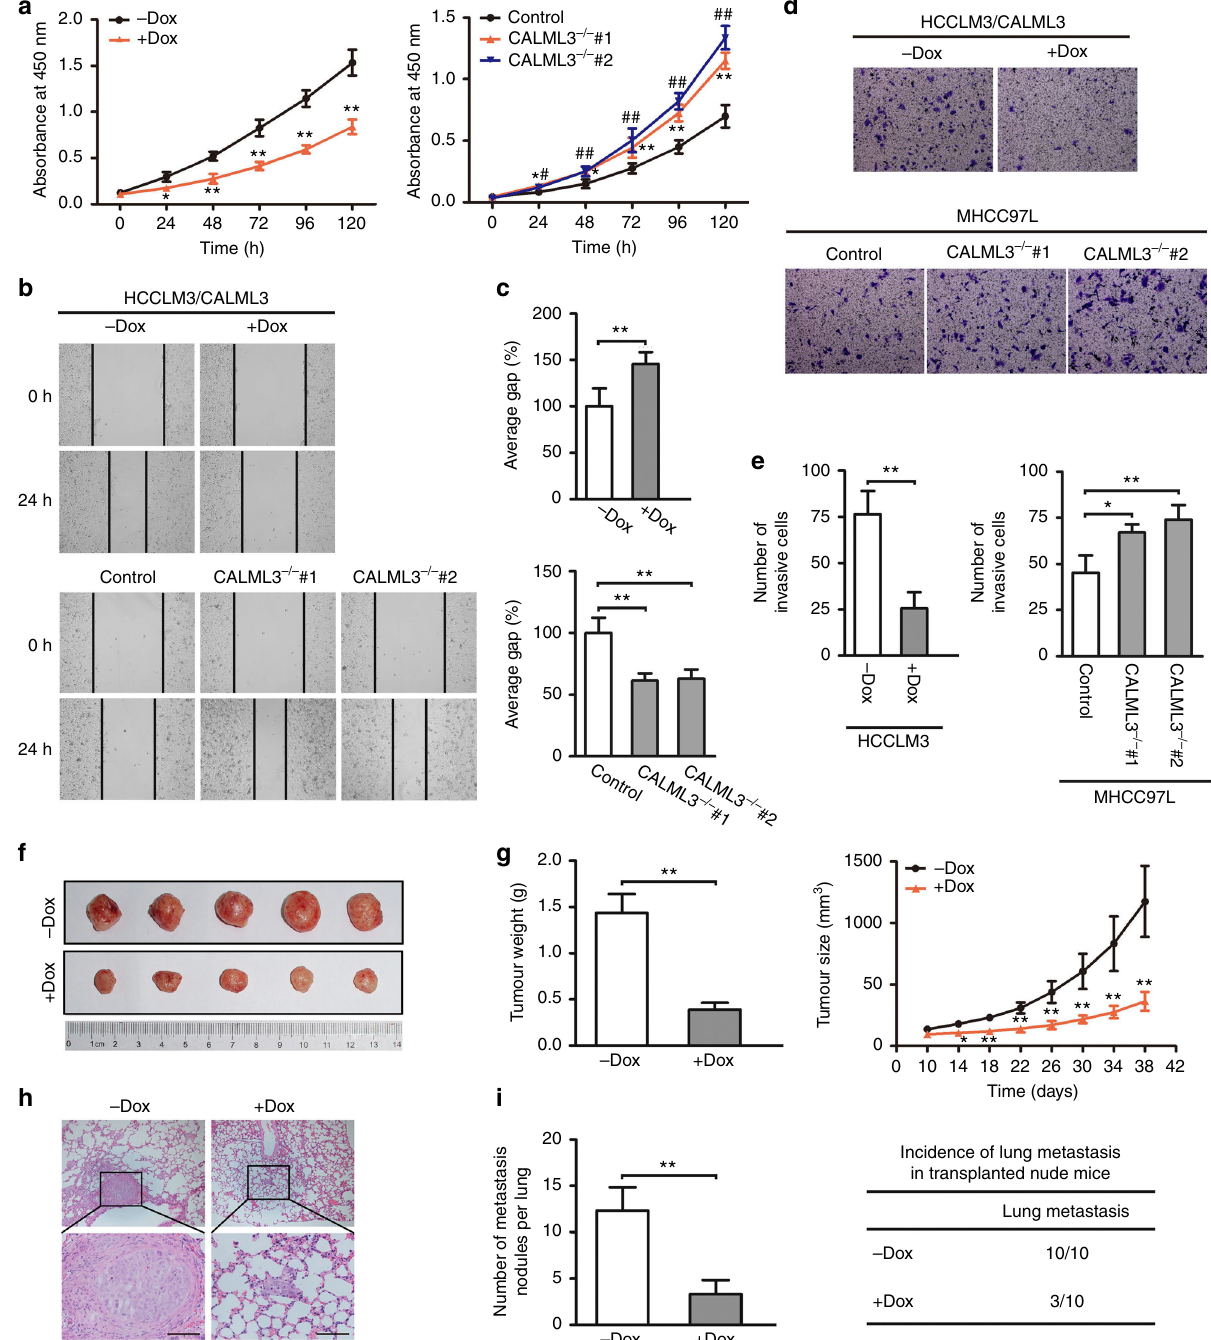
Fig. 4 CALML3 acts as a HCC metastatic suppressor in vitro and in vivo. a CALML3 overexpression in HCCLM3 cells induced by doxycycline (50 ng/ml) for indicated time inhibited cell proliferation, while CALML3 knockout by CRISPR-Cas9 technology promoted cell proliferation. Two clones (CALML3 − / − #1 and CALML3 − / − #2) targeting CALML3 were designed for functional assays. b CALML3 overexpression suppressed cell migration (upper panel) while CALML3 knockout brought the opposite effect (lower panel). c Quanti fi cation of migration cells in the indicated groups in the wound healing assay. CALML3 overexpression showed obvious suppression of migration abilities in HCCLM3 cells (upper panel) while CALML3 knockout induced signi fi cant promotion of migration abilities in CALML3 − / − #1 and CALML3 − / − #2 MHCC97L cells (lower panel). d CALML3 overexpression suppressed cell invasion (upper panel) while CALML3 knockout brought the opposite effect (lower panel). e Quanti fi cation of invasive cells in the indicated groups in the transwell invasion assay. f Tumours from mice implanted with HCCLM3 cells (the control and CALML3 overexpression) in tumour-bearing mouse model. g Comparison of tumour weight and size in tumour-bearing mouse model assay. CALML3 overexpression induced by doxycycline showed less tumour weight and signi fi cantly slowed tumour growth. h Lung tissues from mice implanted with HCCLM3 cells (control and CALML3 overexpression) orthotopic transplantation model were stained with hematoxylin-eosin (scale bar, 100 μ m). i Comparison of pulmonary metastasis in xenografts models. CALML3 overexpression induced by doxycycline showed less lung metastatic nodules and reduced incidence of lung metastasis. Dox: doxycycline. Student's t -test. * P < 0.05, ** P < 0.01. Error bars in panels are de fi ned by SD (standard